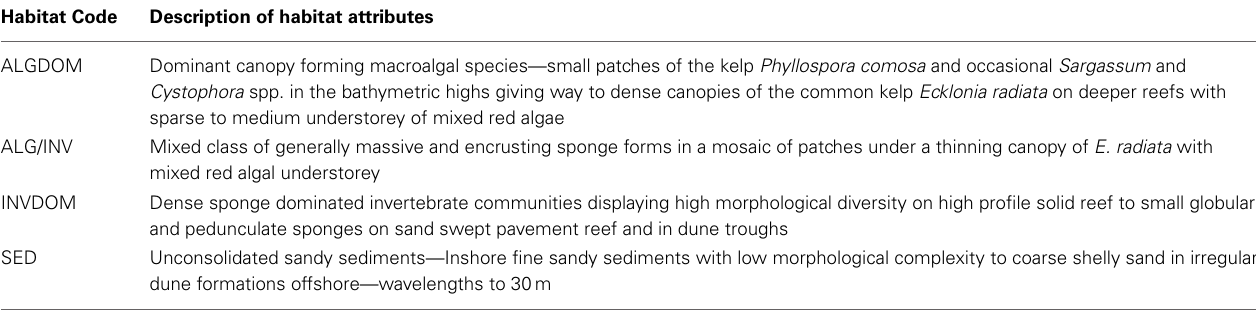
Table 2 | Summary of the four category classification scheme used in the